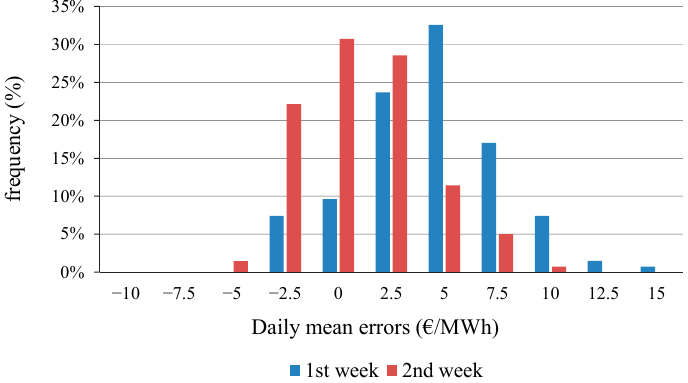
Figure 6. Histogram of daily mean errors for the day-ahead forecast ( D + 1) of prices for the two weeks of the competition.